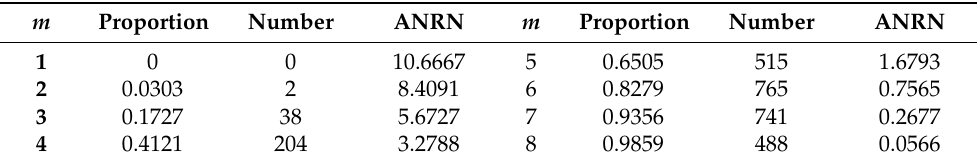
Table 3. The number and proportion of node groups that cause the system to completely fragment and ANRN with 12